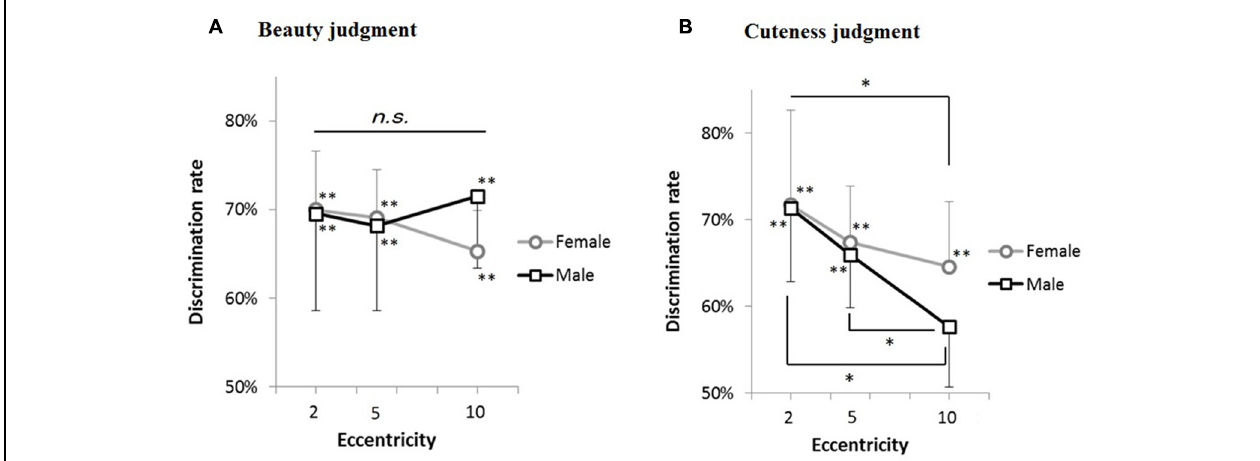
FIGURE 3 | Discrimination rates plotted against viewing eccentricity. (A) Shows the results of judging beauty, while (B) shows the results of judging cuteness. The black and gray lines represent male and female participants, respectively. The error bars show the SEM across stimulus faces. ∗∗ p < 0.01, ∗ p < 0.05.